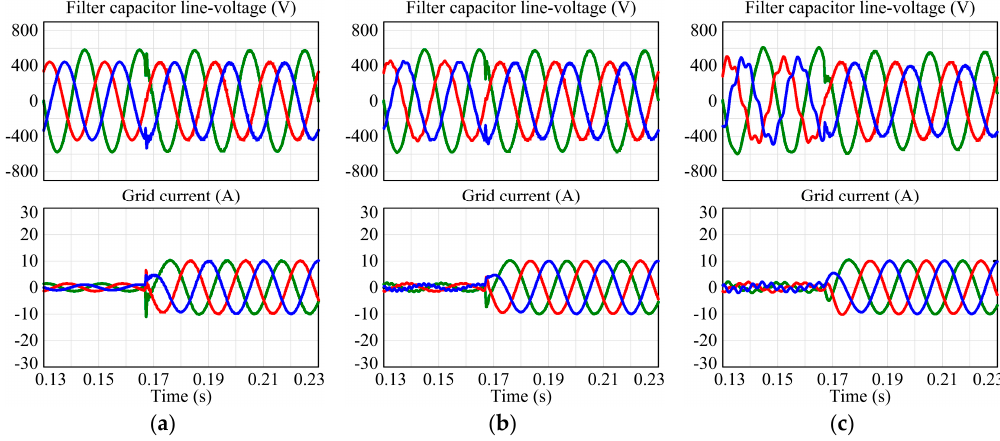
Figure 23. Experimental results of grid-connected converter starting in rectifier mode with Figure 22. Simulation results of grid-connected converter starting in rectifier mode with DFPS-CVFF DFPS-CVFF under unbalanced grid; ( a ) L ’ g = 0; ( b ) SCR = 10; ( c ) SCR = 2. under unbalanced grid; ( a ) L ’ g = 0; ( b ) SCR = 10; ( c ) SCR = 2.